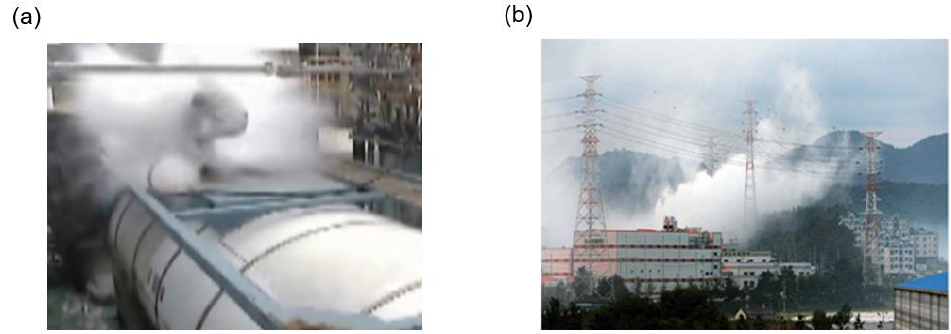
Figure 4. ( a ) Leakage during the operation and ( b ) the spread of anhydrous hydrogen fluoride (HF) around the plant.